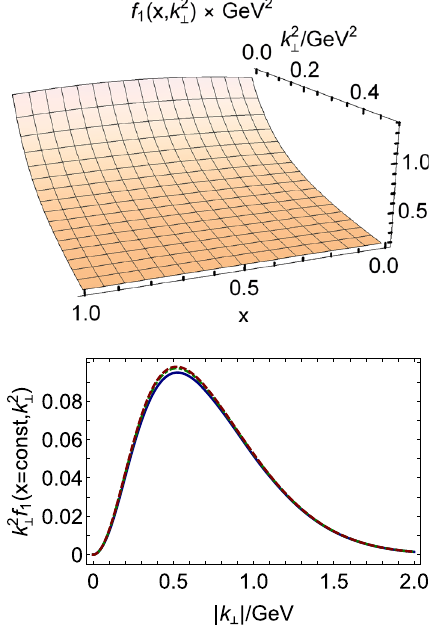
Fig. 9 Upper panel. Twist-three pion TMD, ˆ e ( x , k 2 ⊥ ) , Eq. (73). Lower panel. k 2 ⊥ ˆ e ( x , k 2 ⊥ ) at: x = 0 – solid blue curve; x = 1 / 3 – dot-dashed green curve; x = 2 / 3 – dashed dark-red curve; and x = 1 – short- dashed orange curve. Scale is ζ H , Eq.